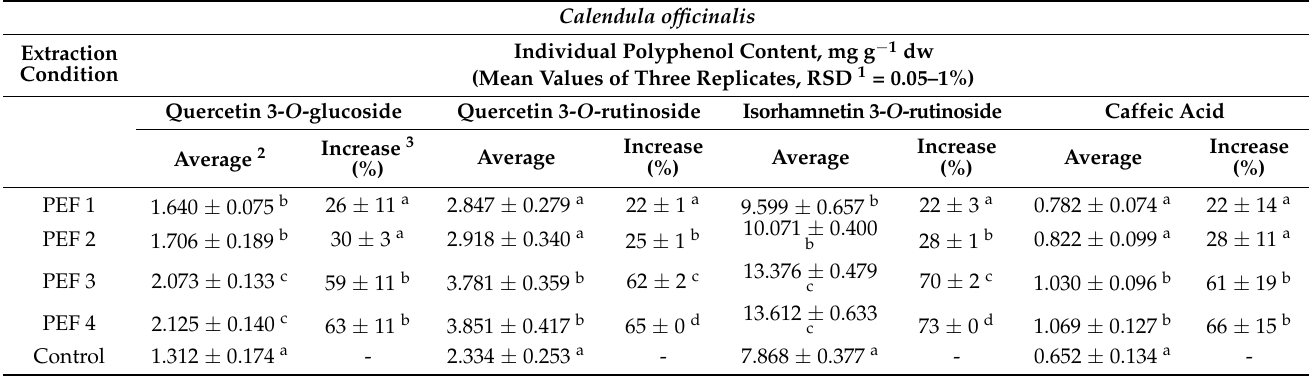
Table 3. Identified polyphenolic compounds of Calendula officinalis (flowers) extracts. Calendula officinalis Extraction Condition (Mean Values of Three Replicates, RSD 1 = 0.05–1%)